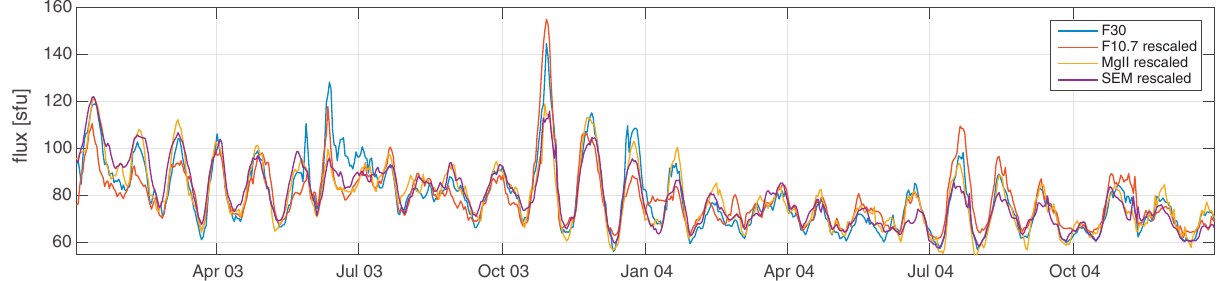
F30 F10.7 rescaled MgII rescaled SEM rescaled